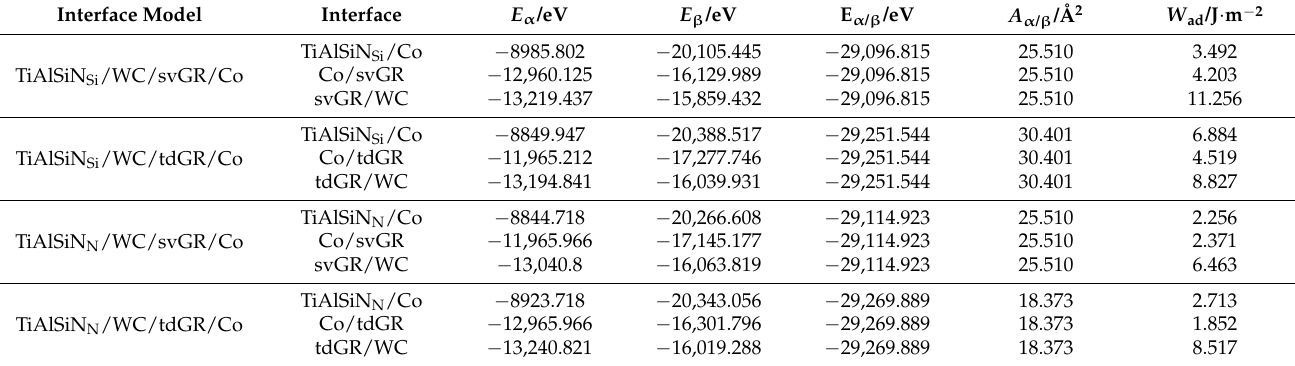
Table 3. Adhesion works of matrix doped with defective